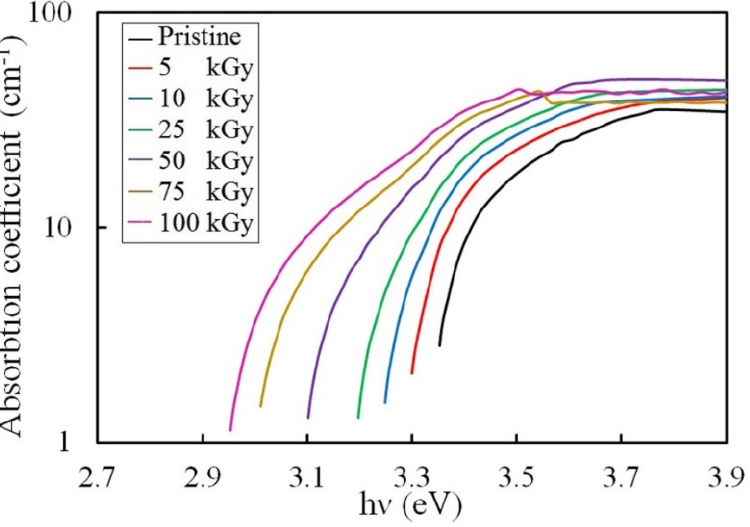
Figure 6. The absorption coefficient spectra of the irradiated and pristine NC films.